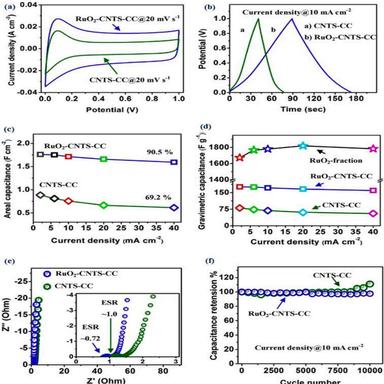
Electrochemical Performance of Electrodes: (a) CV comparison, (b) GCD curves, (c) areal capacitance, (d) gravimetric capacitance, (e) Nyquist plots, (f) cyclic stability. Reproduced from Ref. ..